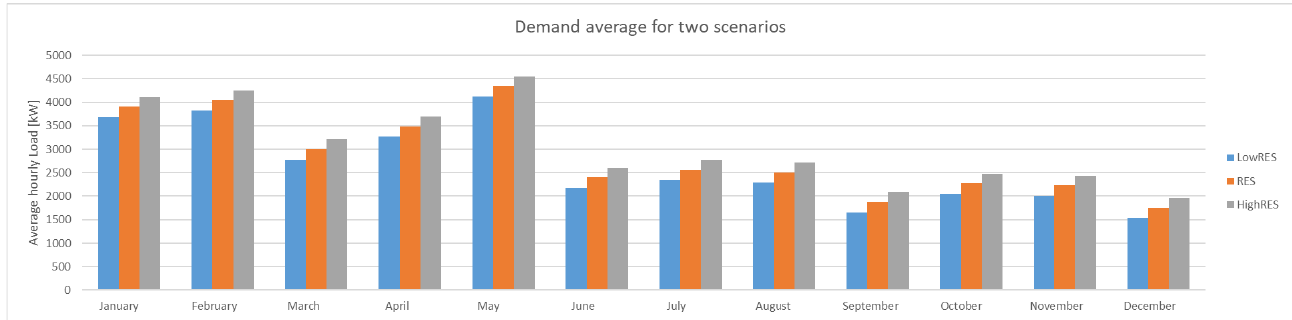
Figure 2. Average monthly load demand for Procida Municipality in 2030 for all scenarios.